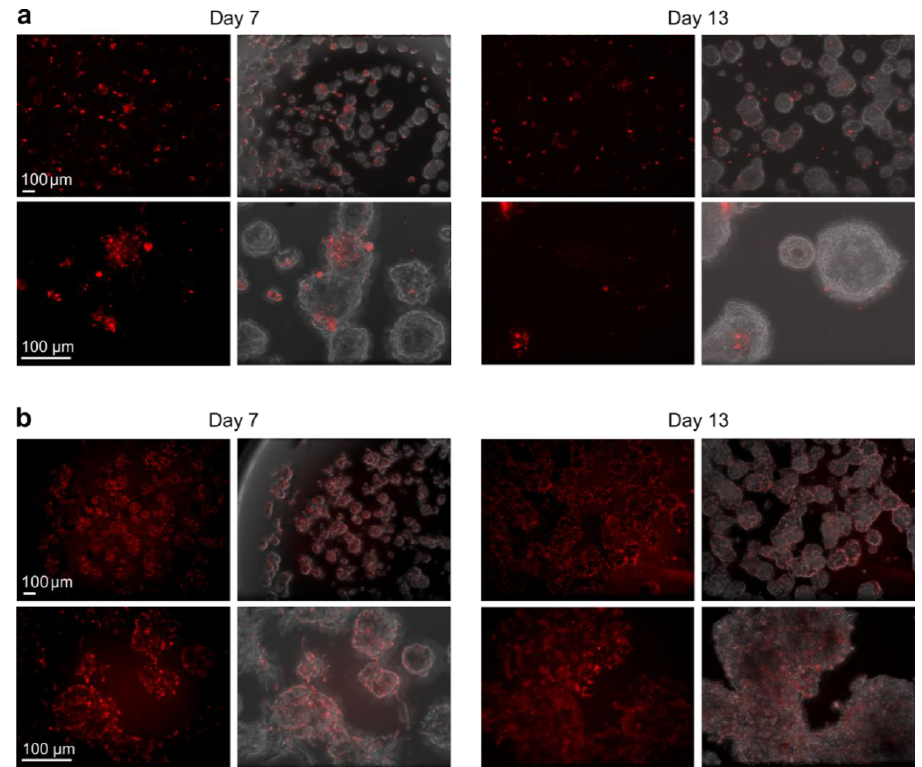
Figure 9. Labeling efficiency of DiI dye as delivered by PEI-MSNs in LNCaP 3D organoids. Comparison of the labeling efficiency of DiI loaded in PEI-MSNs in LNCaP cells when added to cells in 2D culture and then transferred into 3D culture ( a ), or when added directly into the 3D culture, at day 3 ( b ), in a concentration of 10 µ g/mL. Confocal images show the red fluorescent cargo (DiI), which has been monitored at two different time points (day 7 and 13 of 3D culture) inside the tumor organoids (bright